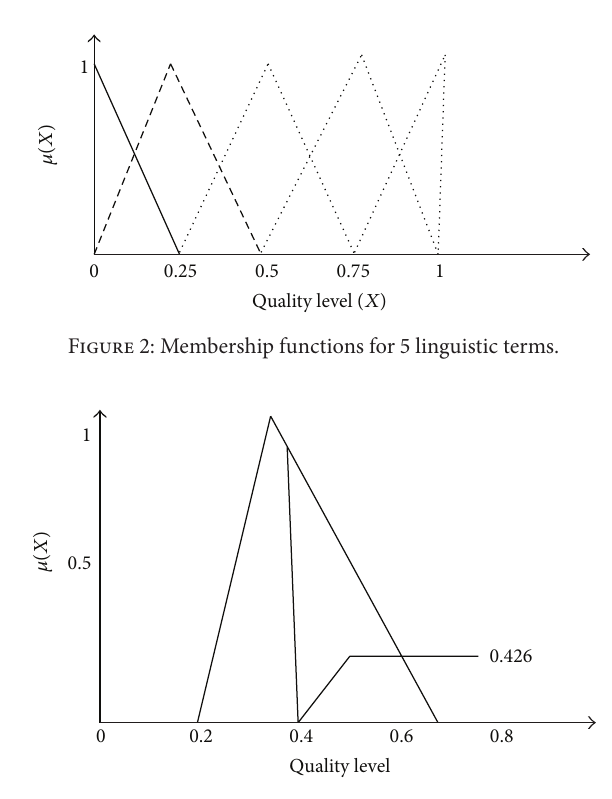
Figure 3: Combined membership function of the